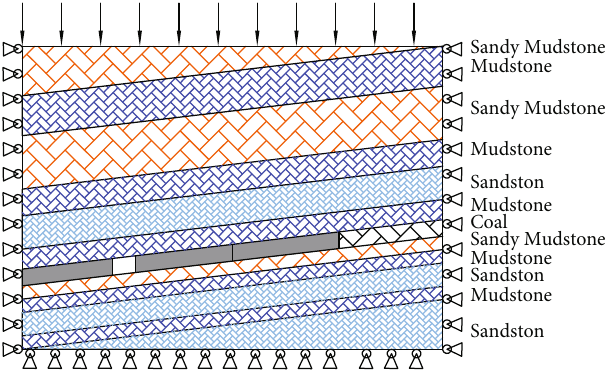
Figure 6: Numerical model.